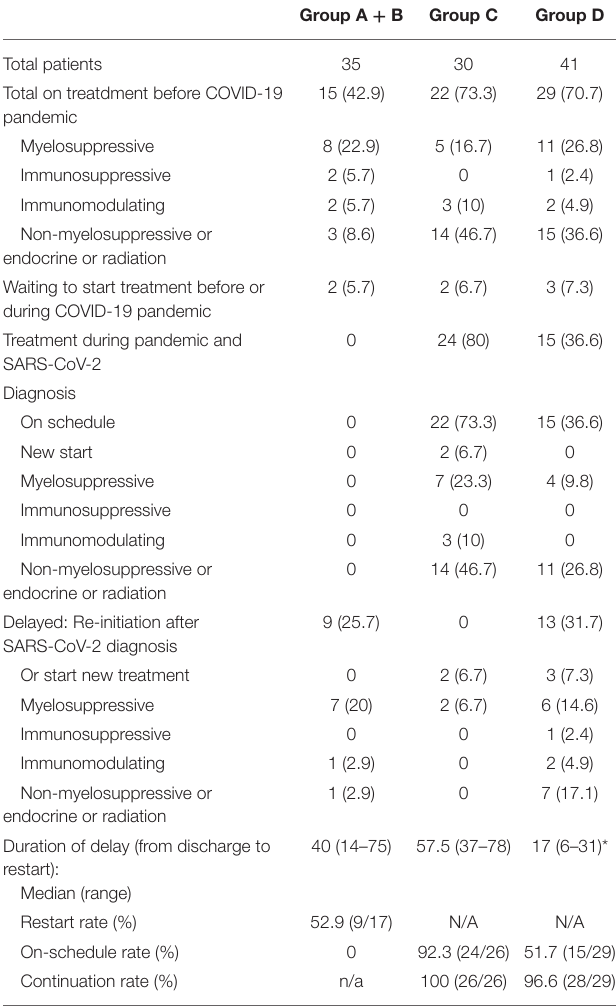
TABLE 6 | Treatment before, during, and re-initiation after SARS-CoV-2 diagnosis. Group A + B Group C Group